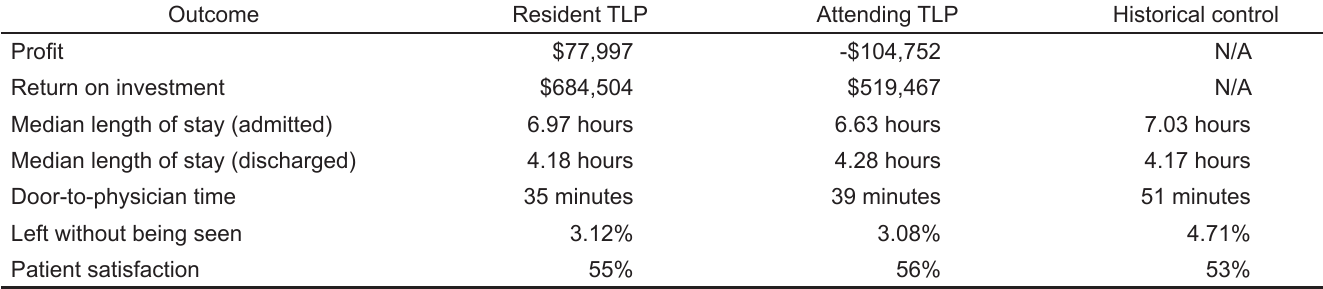
Table. Comparison of resident TLP, attending TLP, and historical control.